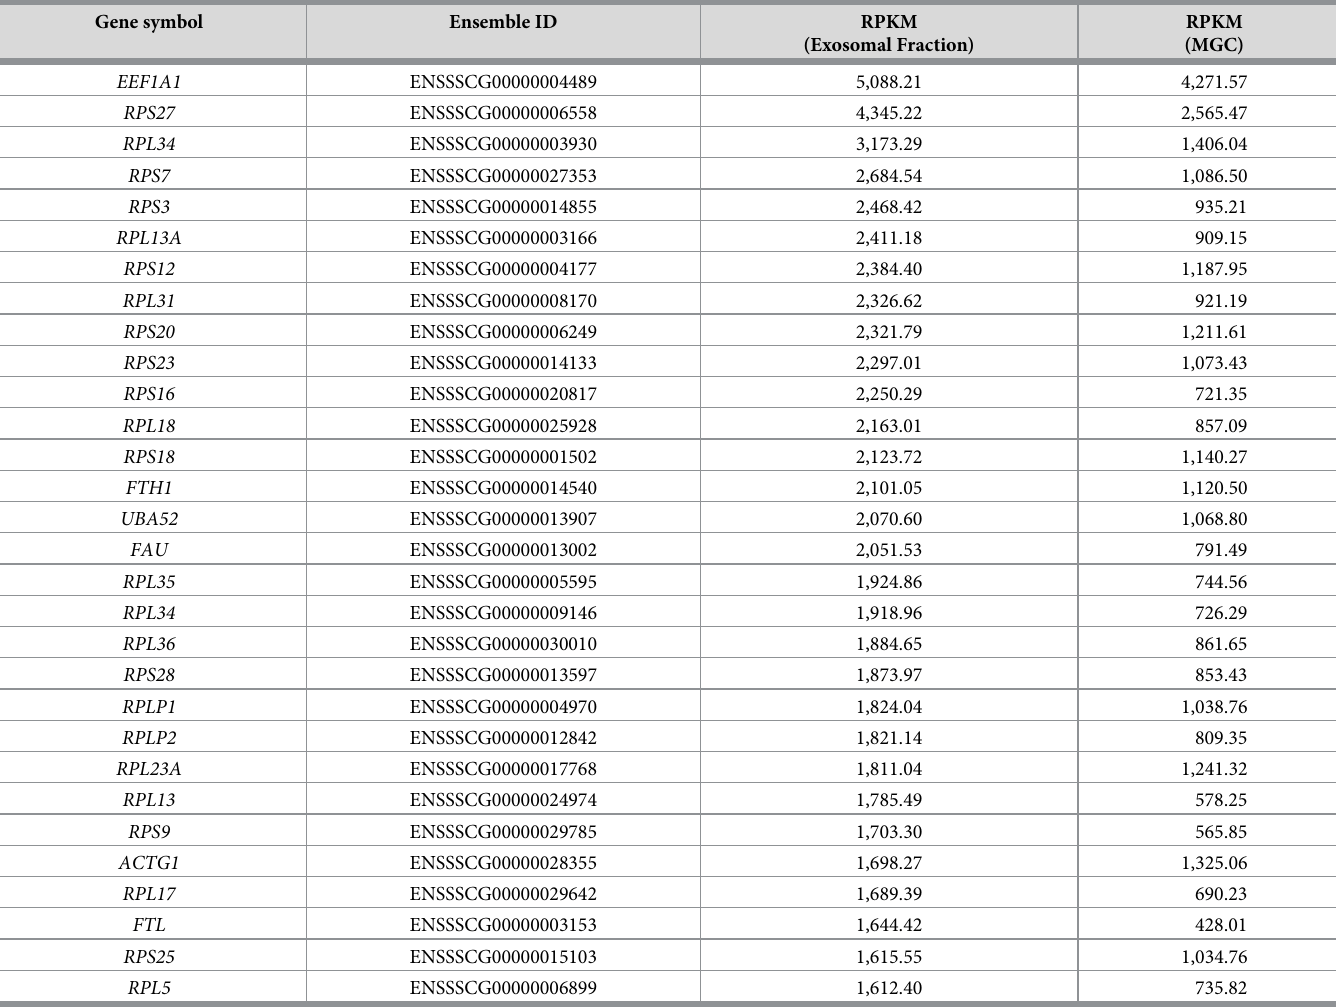
Table 1. Top 30 most abundant mRNAs in exosome-like vesicles in